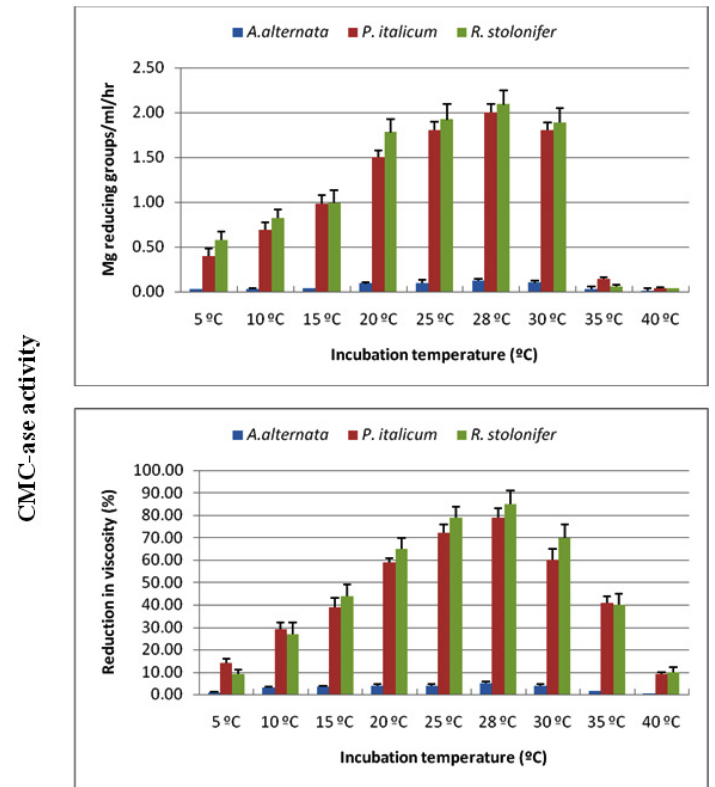
Fig. 3. Effect of incubation temperature on production of CMC-ase using Czapek Dox medium amended with cellulose as carbon source for A. alternata , P. italicum and R. stolonifer after 8 days incubation in the dark. All the data are the mean of three replications and Bar on each column represents the standard